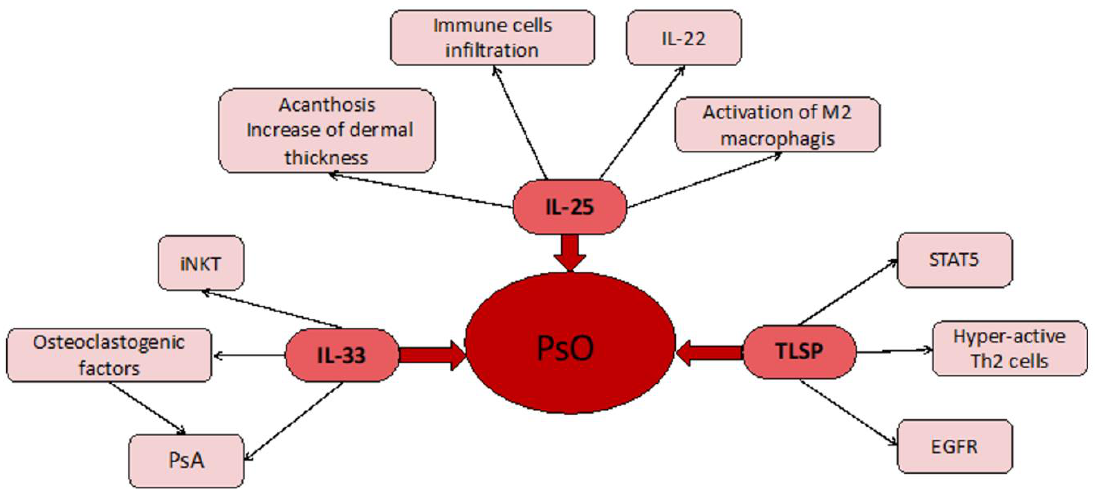
Figure 1. At the center we have the main disease (Pso). This is linked to the three cytokines (TSLP, IL-25, IL-33) used in studies. Depending on the cytokine, we find different manifestations and local responses.